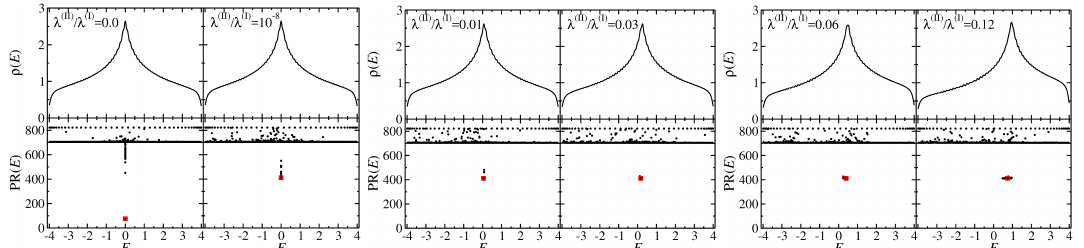
Figure 3. Density of states ρ ( E ) (upper panels) and the corresponding participation ratios PR loc ( E ) for all eigenstates of the fundamental vibration of a 42 × 42 square lattice with square shape and with Dirichlet boundary conditions. They are shown for six values of the relative second-neighbor hopping interaction strength with respect to that for nearest-neighbor hopping, λ ( II ) / λ ( I ) . Red (dark gray) marks highlight the most localized at the vHs. The detailed λ ( II ) / λ ( I ) -dependence of the PR loc for these two states will be the focus of Section